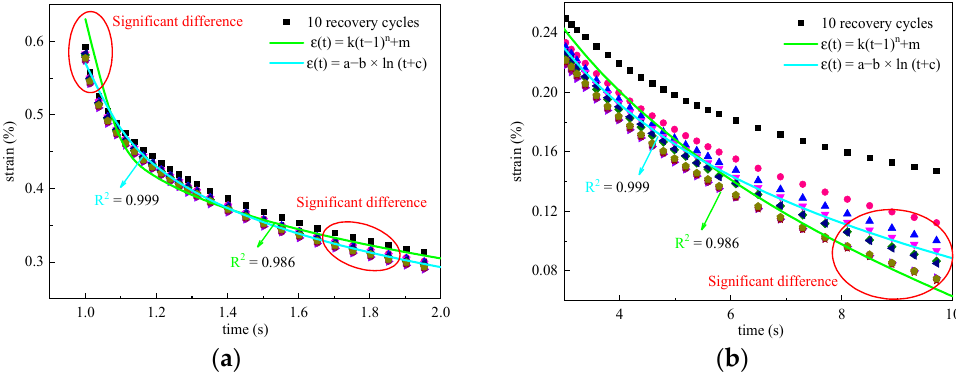
Figure 11. Enlarged view of recovery curves (1.5% PPA at 0.1 kPa and 46 °C): ( a ) Recovery curves for fi rst 2 s; ( b ) recovery curves for 3 s to 10 s.